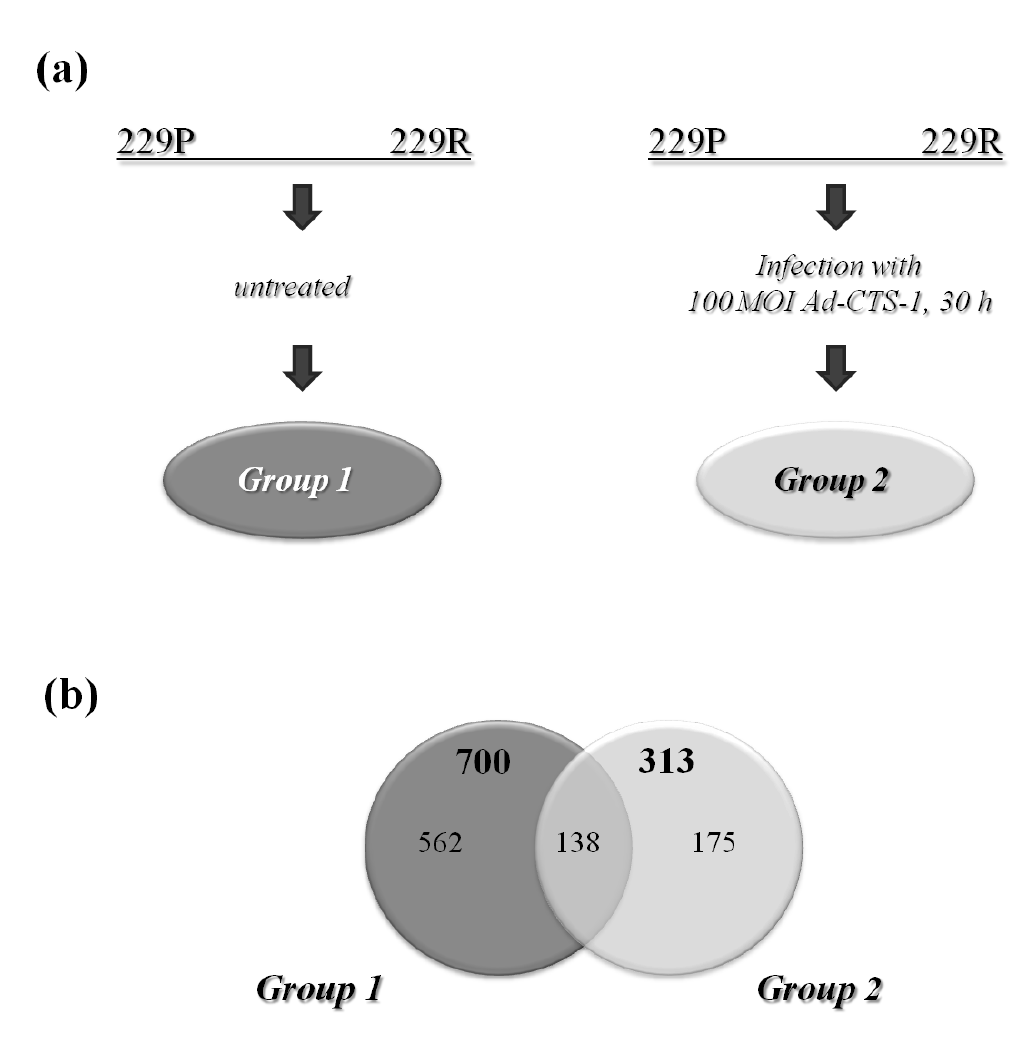
Figure 1. Setting of the whole-genome microarray expression analysis: ( a ). 229P and 229R cells were left untreated (Group 1) or were infected with Ad-CTS-1 (100 MOI, 30 h; Group 2); ( b ). Relationship of numbers of differentially expressed genes in Group 1 (dark-grey) and Group 2 (light-grey). Genes with a fold change of 2.0 or higher and a p-value <0.05 are